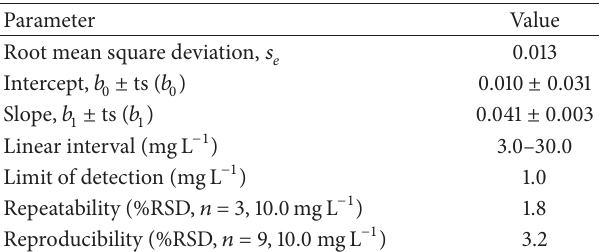
Figure 5: Plot of average effects in the tartrazine recovery. 𝑉 𝑀 : Table 7: Contents of tartrazine (mean and %RSD, 𝑛 = 3) in : magnetic modified carbon; sample volume; 𝑉 𝐸 : eluent volume; 𝑚 C real samples determined with the proposed methodology and and 𝐶 𝐸 : NaOH concentration in the eluent. comparison with HPLC reference Table 5: Parameters of the regression line for signal (AU) versus tartrazine concentration (mgL − 1 ) plot.